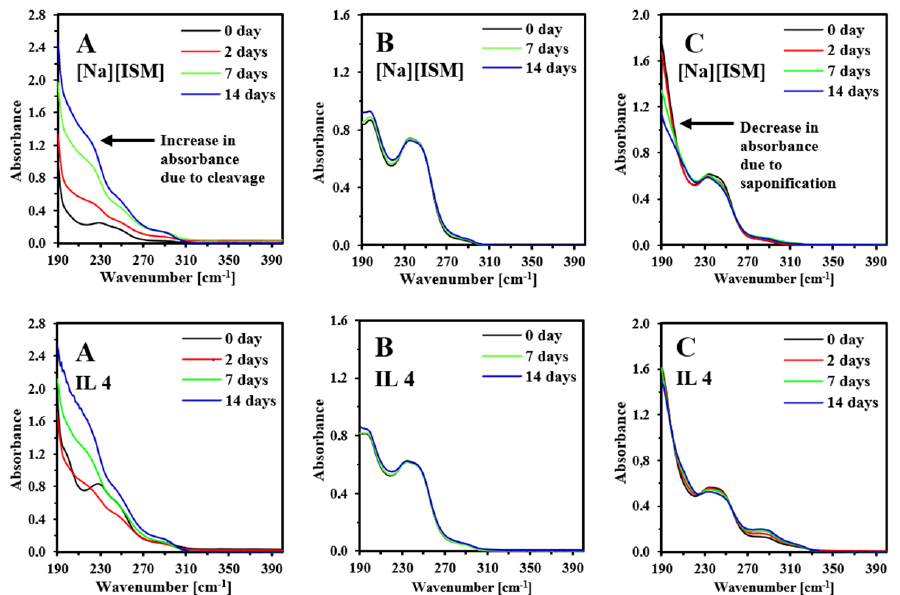
Figure 4. UV spectra of iodosulfuron-methyl sodium salt ( [Na][ISM] ) and IL 4 in acidic ( A ), neutral ( B ) and basic ( C ) environment.